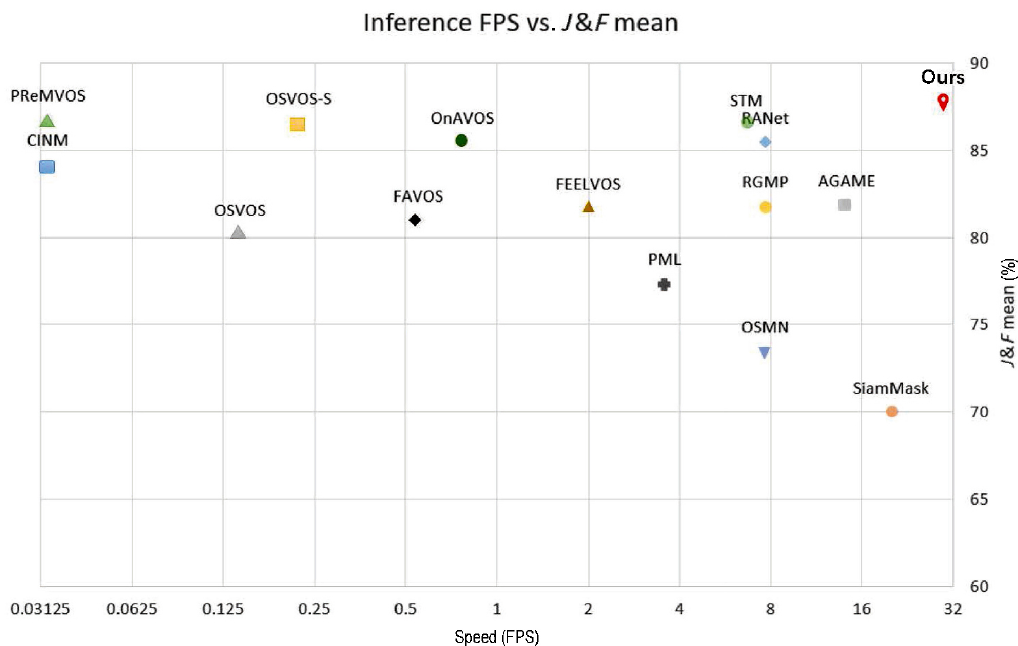
Fig. 7 Speed (FPS) versus accuracy ( J & F mean) comparison using the DAVIS 2016 validation set at 480p